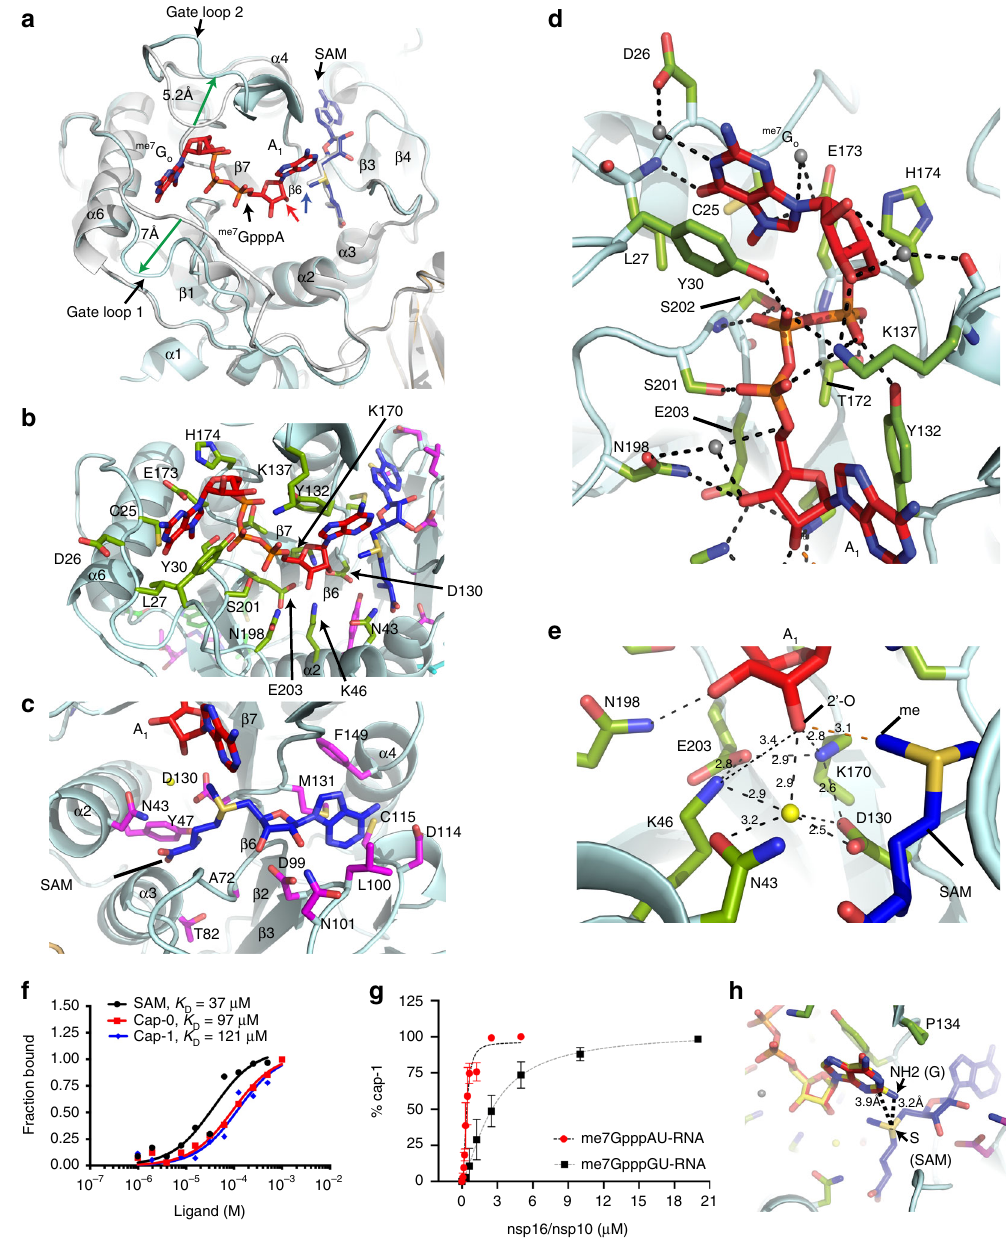
Fig. 2 Binding modes of RNA cap analogues and SAM and mechanism of methyl transfer. a Overlay of a binary (S-adenosyl methionine or SAM-bound; gray cartoons) and ternary (SAM, RNA cap-bound; light cyan cartoons) complexes shows outward motions (green arrows: 7 Å in gate loop 1, and 5.2 Å in gate loop 2) after RNA cap binding to nsp16. RNA cap, red stick; SAM in ternary complex, blue stick; SAM in binary complex, gray stick. b green sticks; nsp16 residues that interact with RNA cap. c magenta sticks; nsp16 residues that contact with SAM. d A close-up view of Cap-nsp16 interactions reveals a network of hydrogen bonding with successive phosphates, me7 G O and A 1 nucleotides of cap. Water, gray spheres, h-bonds, black dashed lines. e A water (yellow sphere) coordinates with the target 2 ′ -O atom of A 1 , and catalytic tetrad residues and N43. The methyl group of SAM is positioned for direct in-line attack from the 2 ′ -O. f Binding isotherms and fi tting of data for nsp16 binding to RNA cap-0 ( me7 GpppA), cap-1 ( me7 GpppAm) analogues, and SAM. Each data point represents average of two independent experiments ( n = 2). g The 2 ′ -O methyltransferase activity measured as percentage of Cap-0 to Cap-1 conversion is plotted against nsp16/nsp10 protein concentration. Higher enzymatic activity is observed on an RNA substrate with A (red circles) as the target base for 2 ′ -O methylation (N 1 ), compared to an identical RNA but with G (black square) as N 1 or initiating nucleotide. Results are average of three independent experiments ( n = 3) with one standard deviation (s.d.) for each RNA shown as error bars. Source data are provided as a Source Data fi le. h Guanine base (yellow stick) is modeled at N 1 position of cognate adenine (red stick). The N2 amine of guanine intrudes into the SAM pocket and may be repelled by positively charged sulfur of SAM (blue